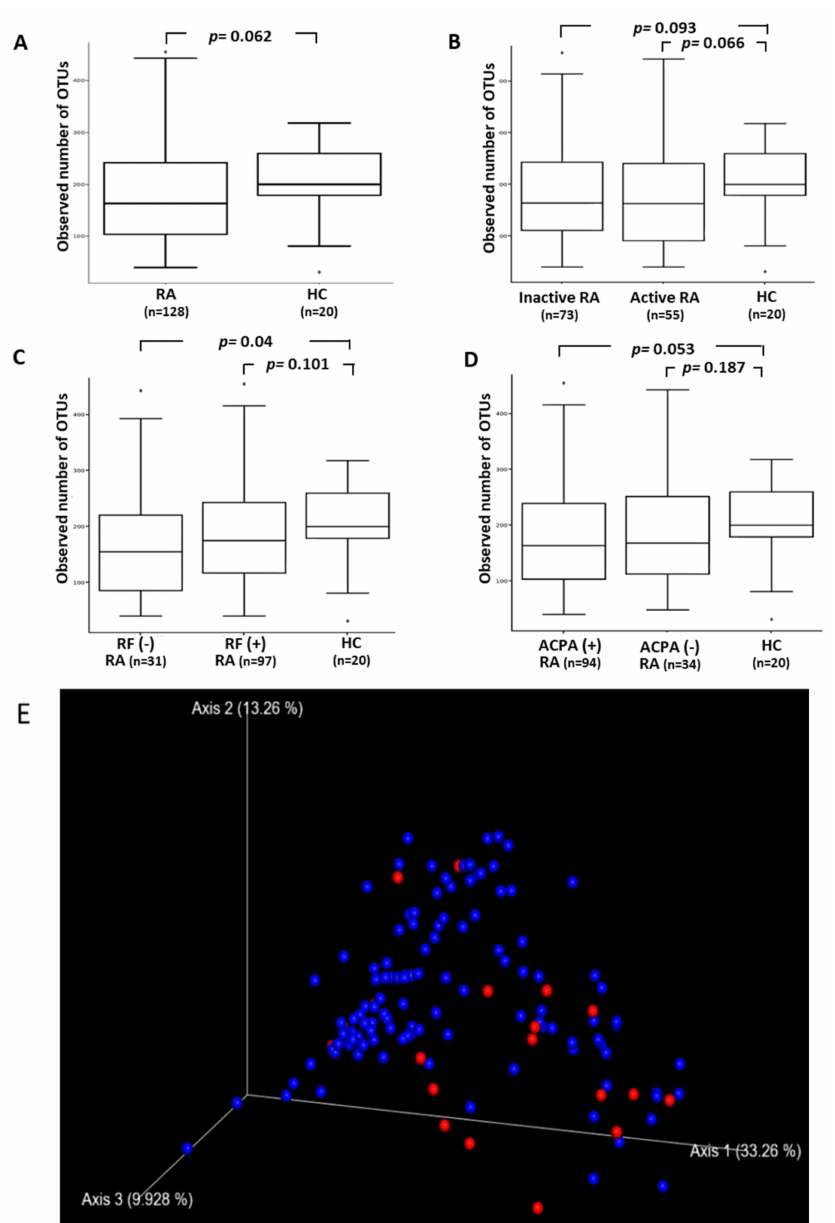
Figure 2. ( A – D ) Comparison of alpha diversity, reflected by the observed OTUs index, among RA patients with di ff erent phenotypes and HC. Active RA was defined as the 28-joint disease activity score more than 3.2. Data are presented as box-plot diagrams, with the box encompassing the 25th percentile (lower bar) to the 75th percentile (upper bar). The horizontal line within the box indicates median value respectively for each group. Principal coordinate analysis (beta diversity) of weighted UniFrac distances between fecal specimens from RA patients (in blue) and HC (in red) (PERMANOVA p -value = 0.009). OTUs: operational taxonomic units; RA: rheumatoid arthritis; HC: healthy controls; RF: rheumatoid factor; ACPA: anti-citrullinated peptides antibodies. The distribution of frequency of features (operational taxonomic unit, OTU) in each sample from patients with rheumatoid arthritis and healthy controls. ( E ) PCoA plot analysis ( β -diversity) revealed the microbial profile distances were significantly di ff erent between RA patients (shown as blue dots) and HC (shown as red